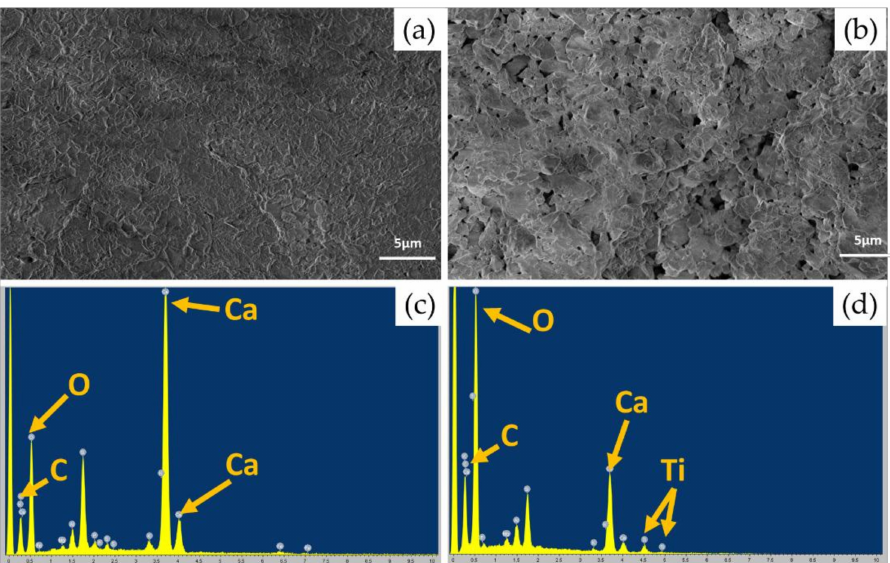
Figure 8. The SEM micrographs of untreated ( a ) PL stone and PL-D ( b ) treated by spray coating and corresponding EDS spectra ( c , d ). The SEM measurements were performed with an accelerating voltage of 1 kV, a working distance of 3.7 mm and an aperture size of 20 µ